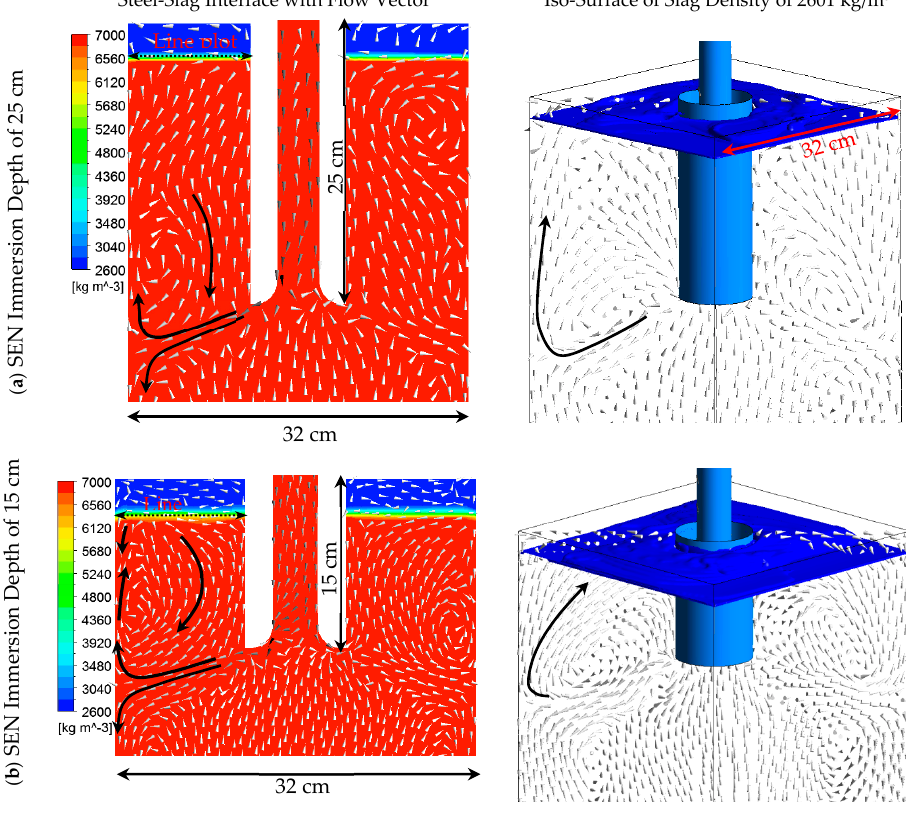
Figure 8. Steel-slag interface with steel flow vectors.